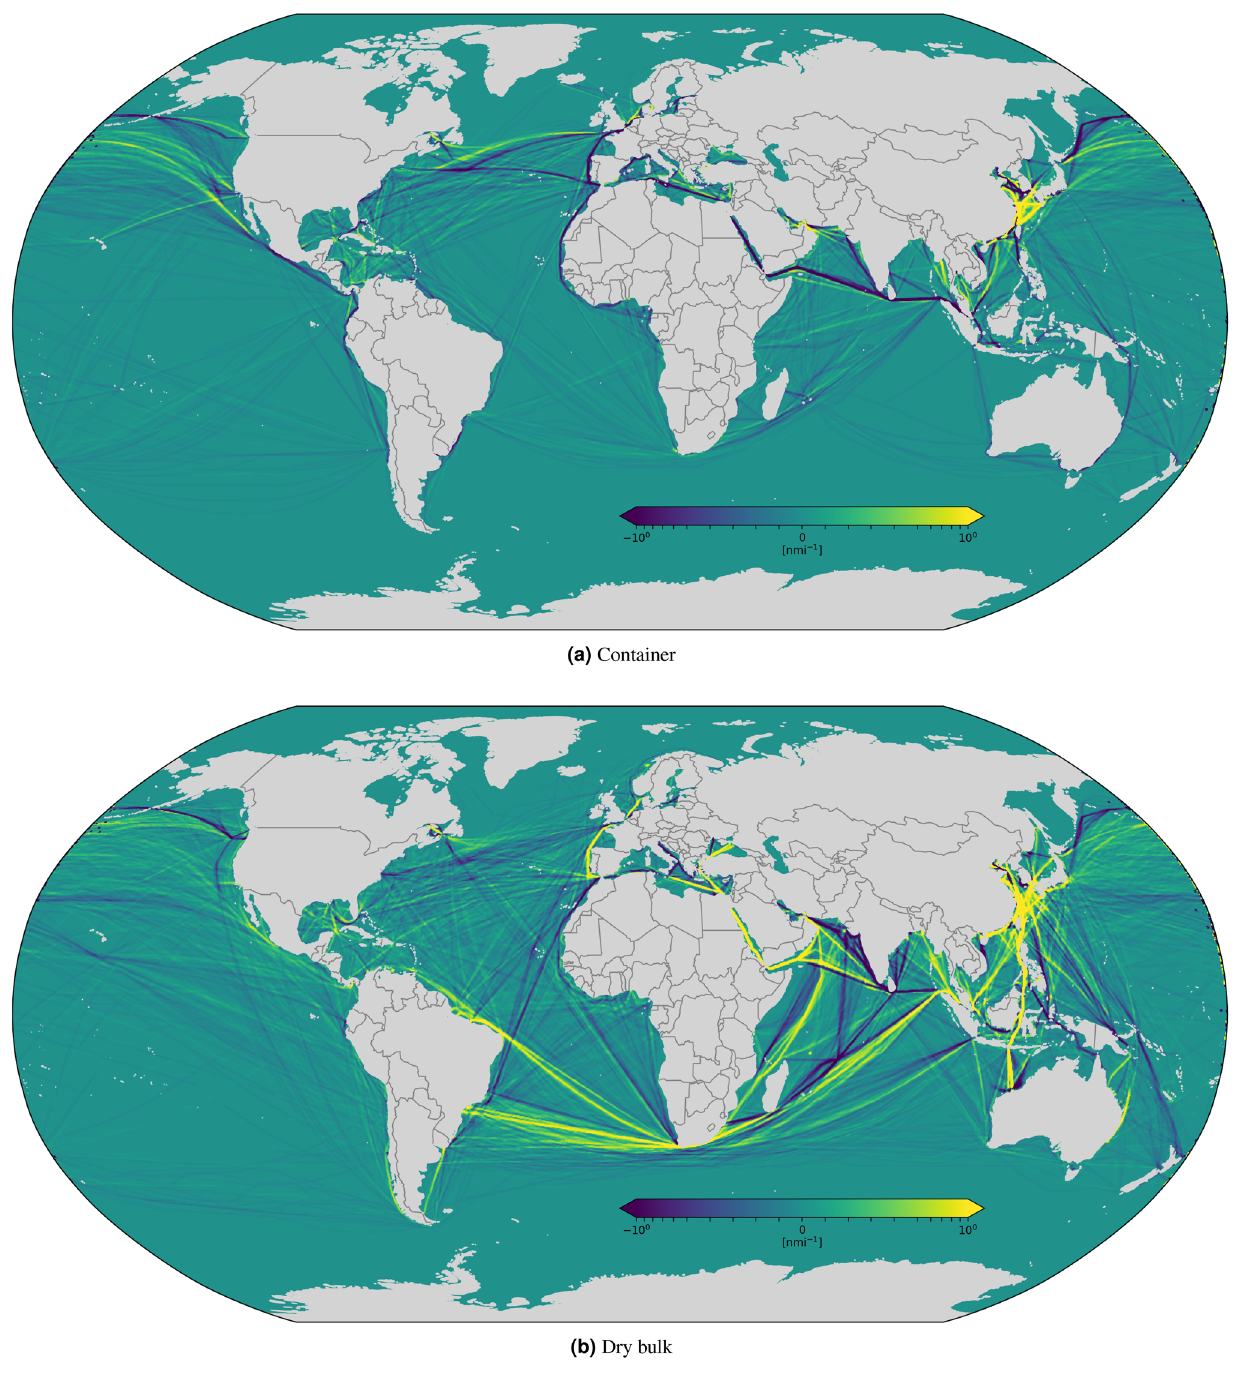
Figure 5. Monthly CNM density difference between 2020 and 2019 for container ( a ) and dry bulk ( b ) shipping. The considered time period is from 13 March to 13 April, taking the difference between 2019 and 2020. Each grid cell is colored based on the variation of the 2020 value with respect to 2019, ranging from dark purple, which represents a decrease of CNM in 2020 with respect to 2019, to bright yellow, which represents instead an increase of navigated miles in 2020 with respect to the previous